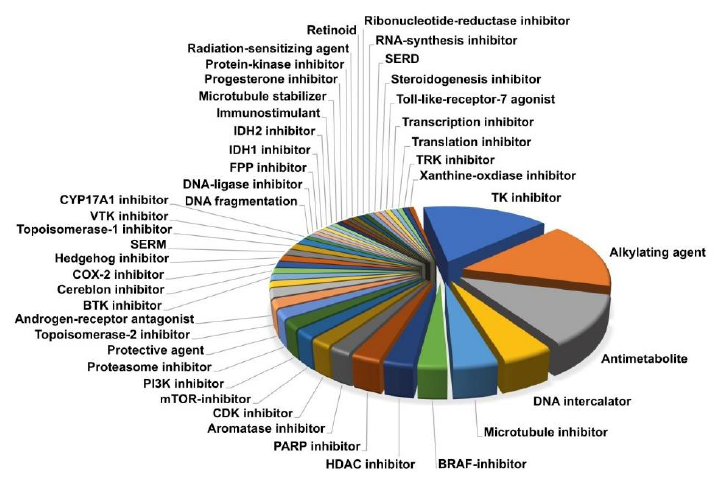
Figure 1. The drug library covers a broad spectrum of substance classes ( n = 44), including a considerable range of anti-neoplastic modes of action used in modern cancer therapy.